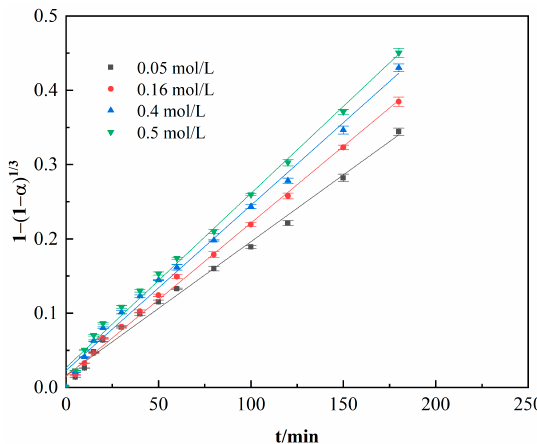
Figure 10. Relationship between 1 − (1 − α ) 1/3 and t at different fluoride ion concentrations.